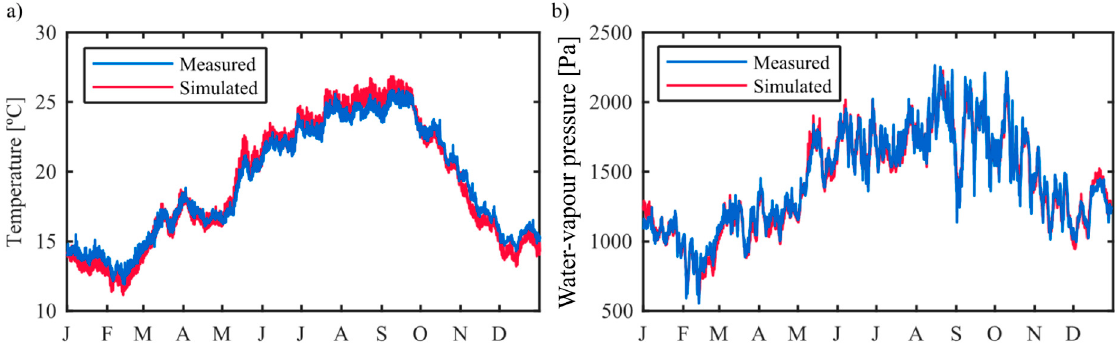
Figure 2. Simulated and measured indoor temperature ( a ) and water-vapor pressure ( b ) variations for the St. Cristóvão model (adapted from Ref. [16]).